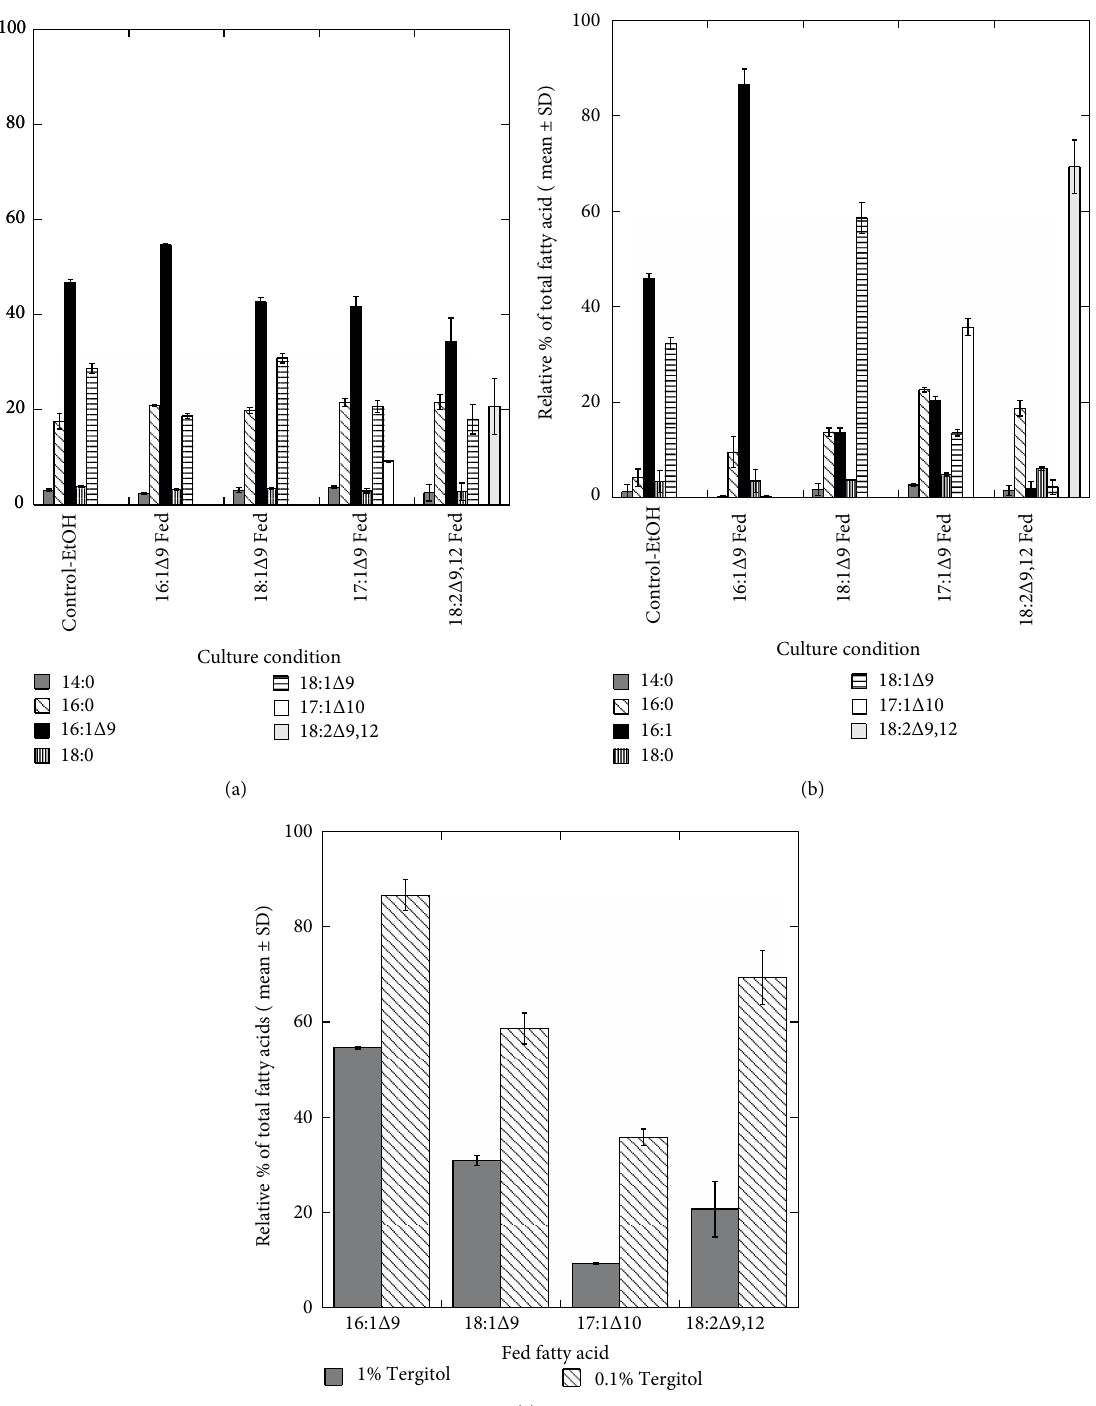
Figure 1: Fatty acid composition of cells grown ± unsaturated fatty acids. Strain W303-1A was grown overnight and refreshed into YNBt medium with either 1% tergitol or 0.1% tergitol, containing 1 mM noted fatty acid, or ethanol for control, for four hours. Cells were harvested, fatty acid methyl esters prepared and analyzed by GC as described in Section 2. At least three replicates were analyzed for each growth condition. Fatty acid profiles of cells grown in the presence or absence of unsaturated fatty acid supplements in either (a) 1% tergitol or (b) 0.1% tergitol. (c) A comparison of the relative amount of fed UFA present in 1% and 0.1% tergitol culture